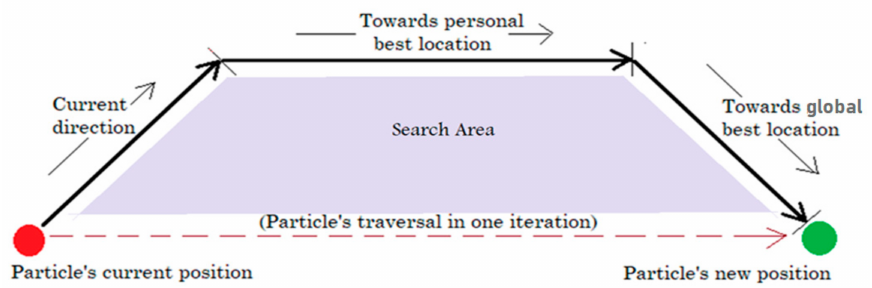
Figure 1. Particle swarm optimization (PSO) search